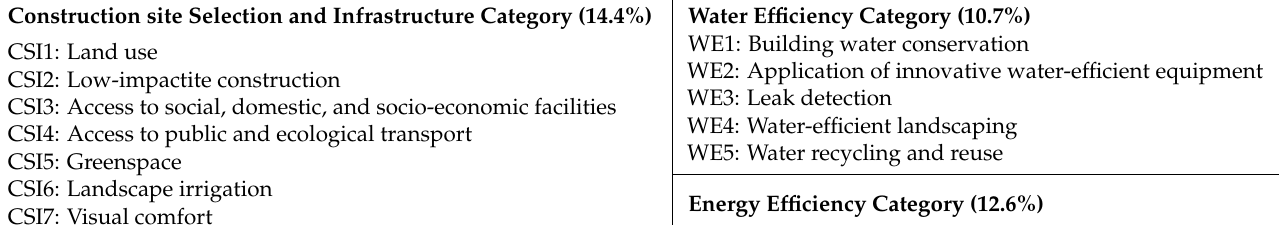
Table 1. List of KBSAF assessment categories, indicators, and category weights (adapted from [15,16]). Construction site Selection and Infrastructure Category